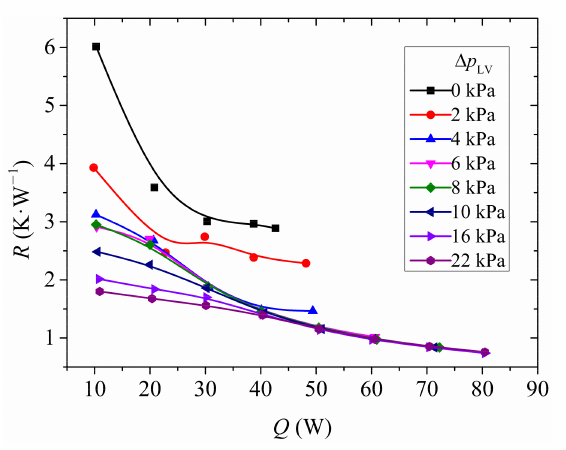
Figure 7. Variation in thermal resistance under different liquid-vapor pressure differences and heating